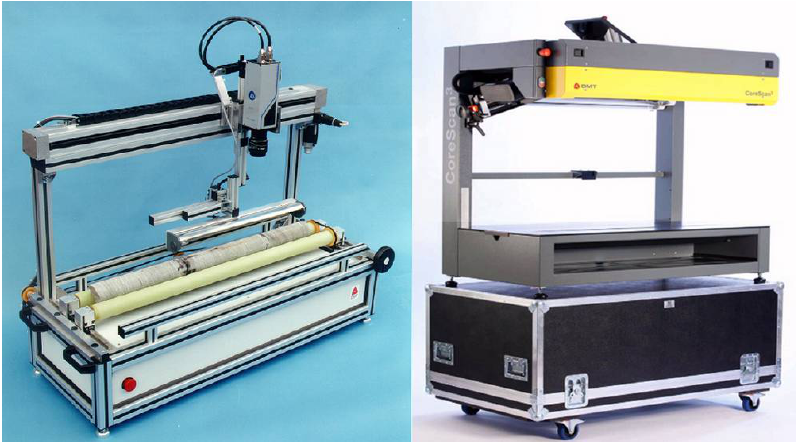
Figure 2: Line scanning devices producing digital core images: DMT Core Scan Color (left), DMT